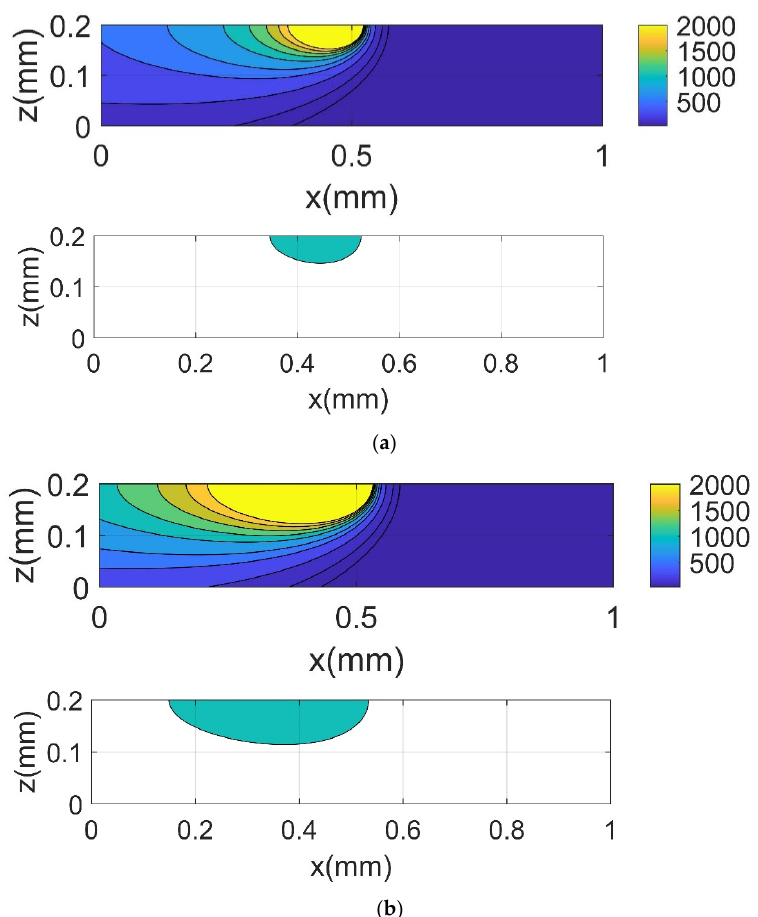
Figure 1. Calculated temperature profiles and molten pool shapes. Color bars show the temperature values. The green shapes are molten pool geometries. ( a ) Temperature distribution (top) and molten pool (bottom) of Case 1 (Power=100W, Speed=500mm/s). ( b ) Temperature distribution (top) and molten pool (bottom) of Case 7 (Power=195W, Speed=500mm/s).